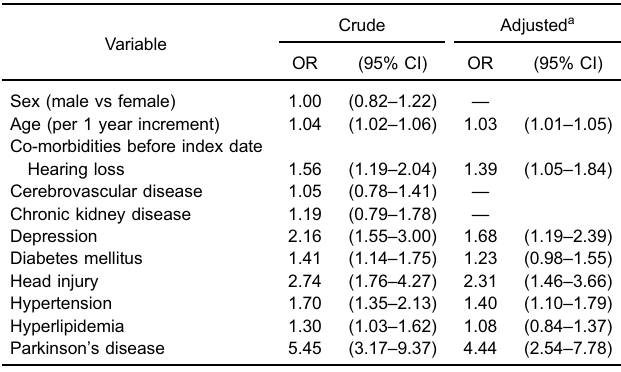
CI, con fi dence interval; OR, odds ratio. a Adjusted for age, hearing loss, depression, diabetes mellitus, head injury, hyperlipidemia, hypertension, and/or Parkinson ’ s